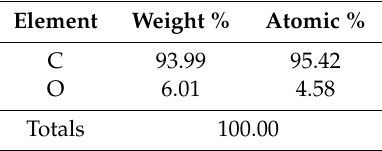
Figure 6. EDS of the graphite sensor window surface for the SPCE. Table 2. EDS showing the composition of the graphite sensor window for the SPCE.